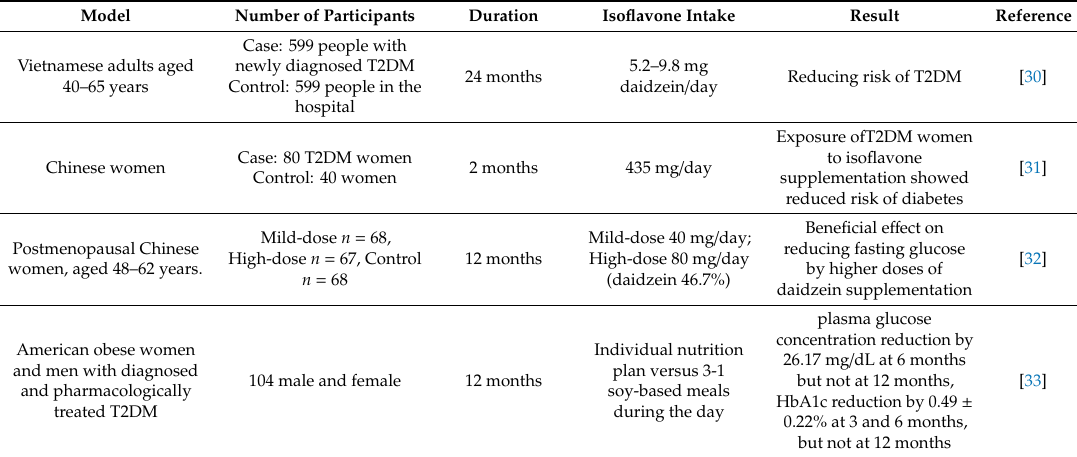
Table 1. Observational studies on the e ff ect of isoflavone intake and risk of diabetes.